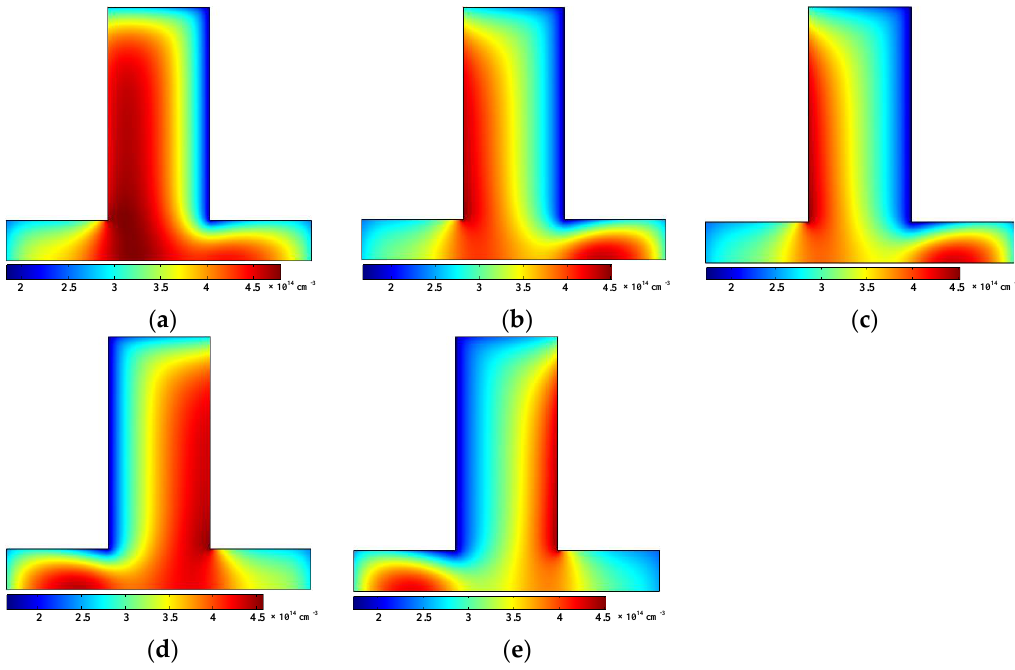
Figure 11. Spatial distribution of the electron density at time ( a ) 2 ms, ( b ) 6 ms, ( c ) 10 ms, ( d ) 14 ms, and ( e ) 18 ms for the reactor at 22 kV AC voltage and 1 cm distance between electrodes.